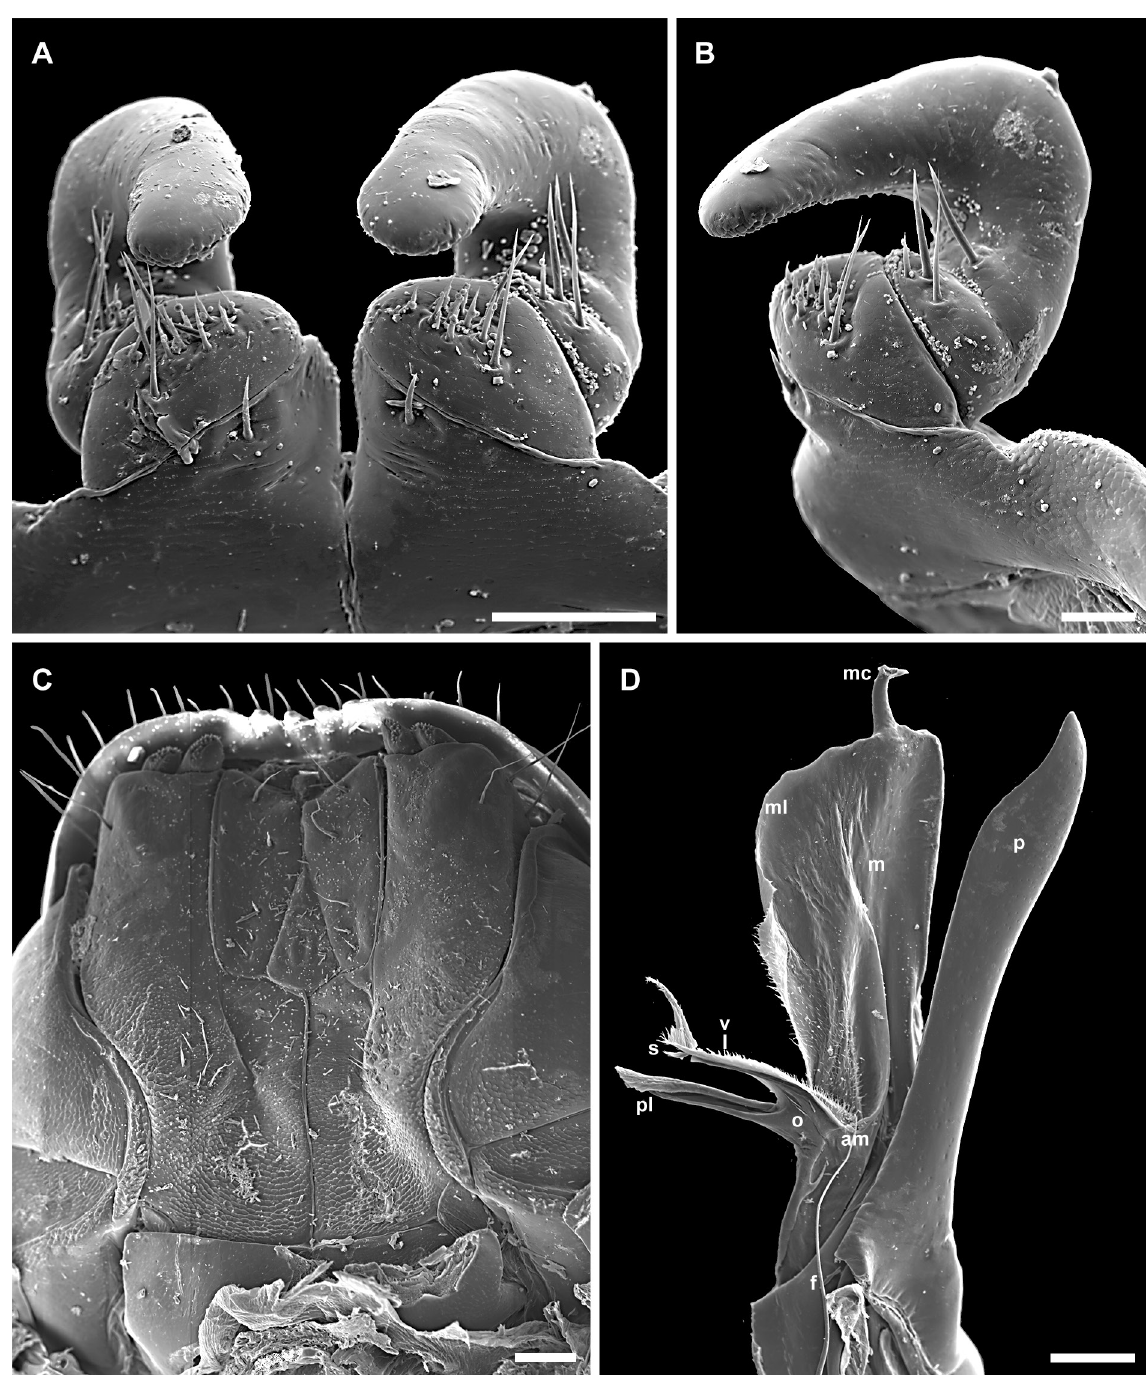
Fig. 23. Leucogeorgia golovatchi sp. nov., paratype ♂ from Tsakhi Cave (ZMUM). A . Leg-pair 1, anterior view. B . Right leg 1, lateral view. C . Head, ventral view. D . Right gonopods, mesal view. Abbreviations: am = accessory membrane; f = flagellum; m = mesomere; mc = mesomeral claw; ml = mesomeral lamella; o = opisthomere; p = promere; pl = protective lamella; s = solenomere; v = velum. Scale bars: A, C–D = 0.1 mm; B = 0.05